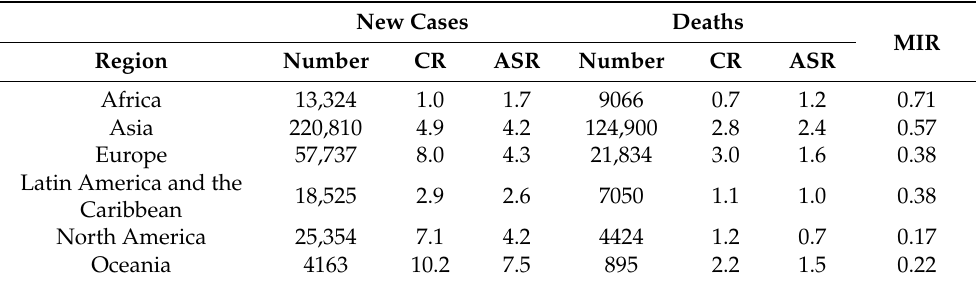
Table 1. Summary of the number, crude rank, ASR, and MIR of lip and oral cancer by region.